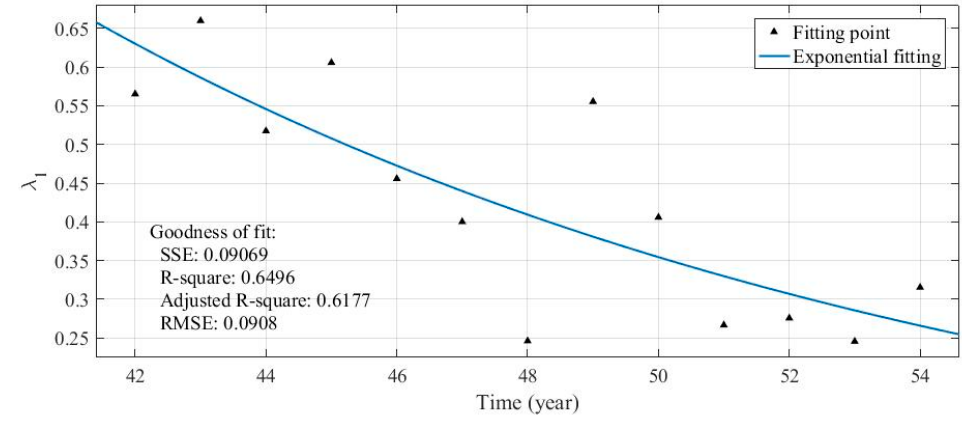
Figure 11. Scale parameter ( λ 1 ) fitting ( f c = 18.0 N/mm 2 ).